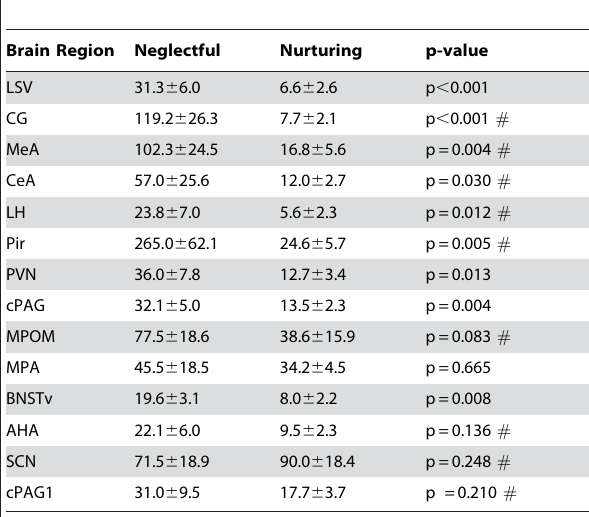
See Fig. 6 for c-Fos in dopamine releasing and responding regions. Abbreviations: LSV=lateral septum ventral; CG=cingulate cortex; MeA=medial amygdala; CeA=central amygdala; LH=lateral hypothalamus; Pir=piriform cortex; PVN=paraventricular nucleus; cPAG=caudal periaqueductal gray; cPAG1=more caudal aspect of cPAG; MPOM=medial preoptic nucleus; MPA=medial preoptic area; AHA=anterior hypothalamic area; SCN=suprachiasmatic nucleus. # - data non-normal, analyzed with ANOVA on Ranks.